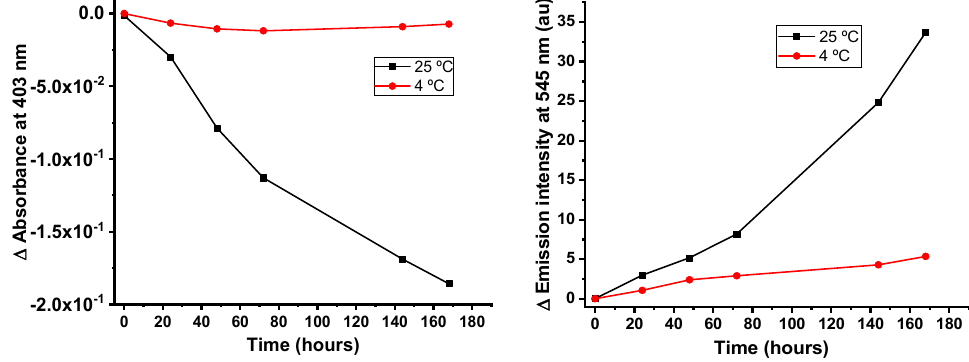
Figure 11. Evolution of the absorbance (left) and fluorescence (right) signals detected with solu- tions of 1 after the decay of fish samples over several hours.